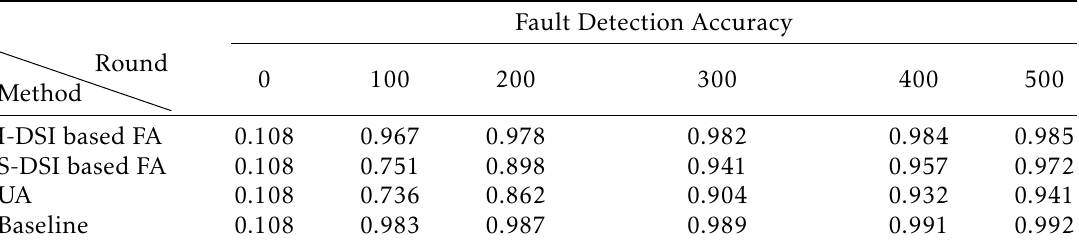
Table 3. Fault detection accuracy of various FA schemes along with MNIST and delay limit β